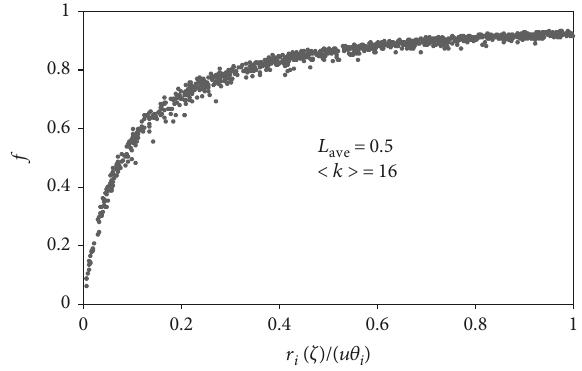
Figure 12: The relationship between the degree risk contagion and y i